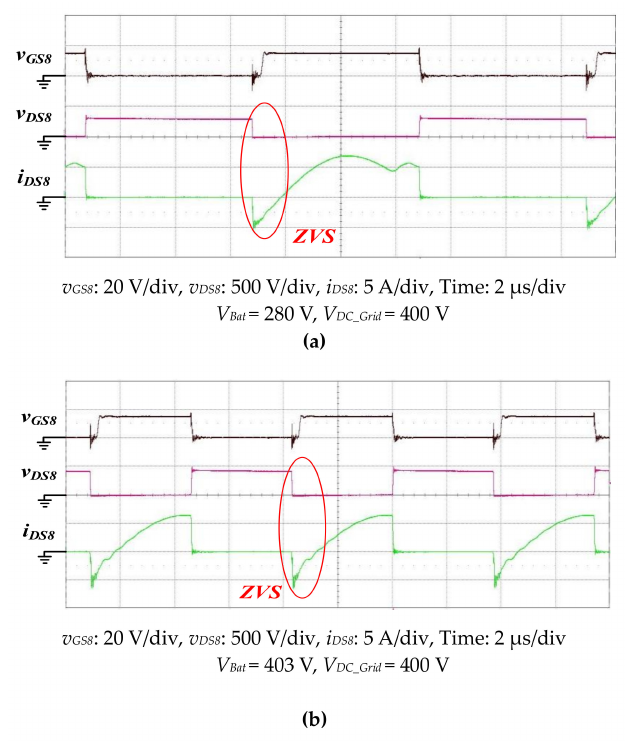
Figure 18. Waveforms of v GS8 , v DS8 , and i DS8 with two discharging battery voltages: ( a ) V Bat = 280 V; ( b ) V Bat = 403